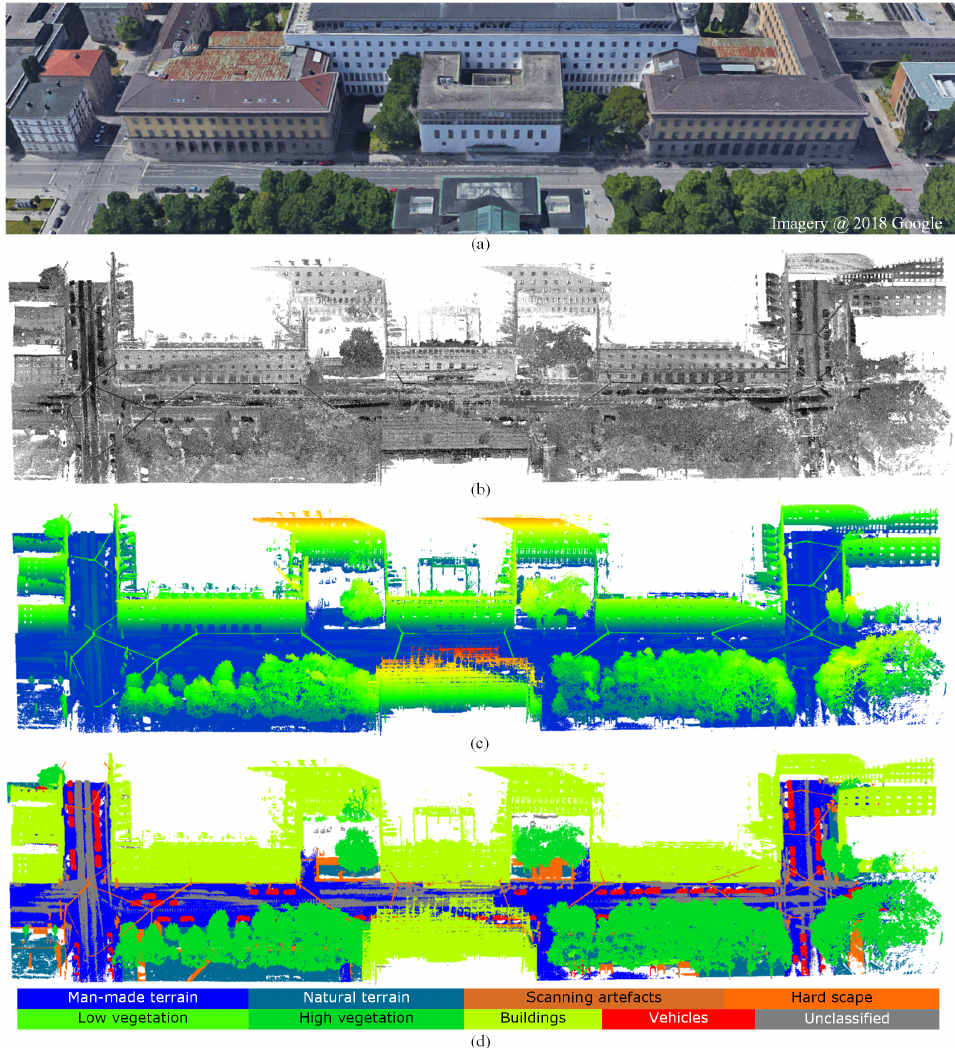
Figure 1. A small example area of the benchmark dataset for semantic labeling. ( a ) Real scene of the TUM main entrance from Google Maps, 2018. ( b ) MLS point cloud with intensities measured by the laser scanners. ( c ) MLS point cloud colored with respect to height. ( d ) Annotated point clouds with eight different semantic